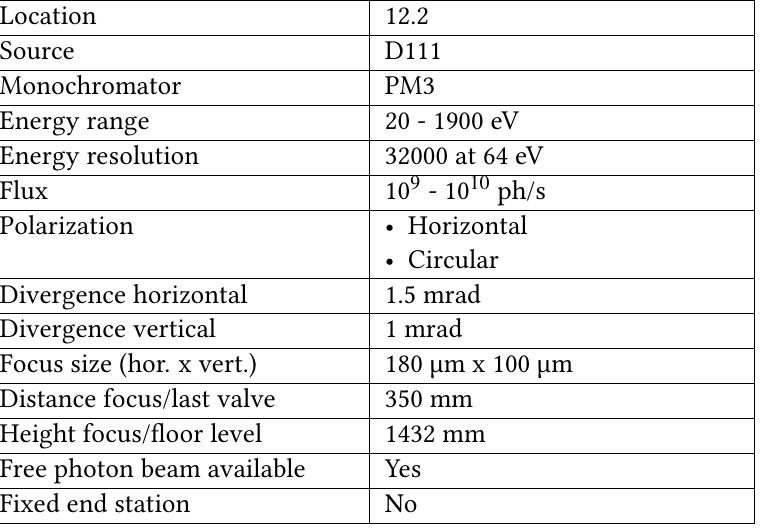
Table 1: Technical parameters of beamline